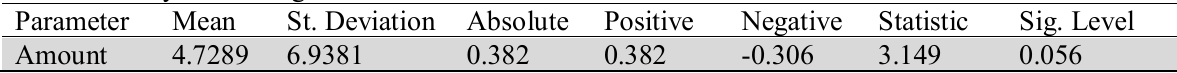
The Summary of Kolmogorov's Test Parameter